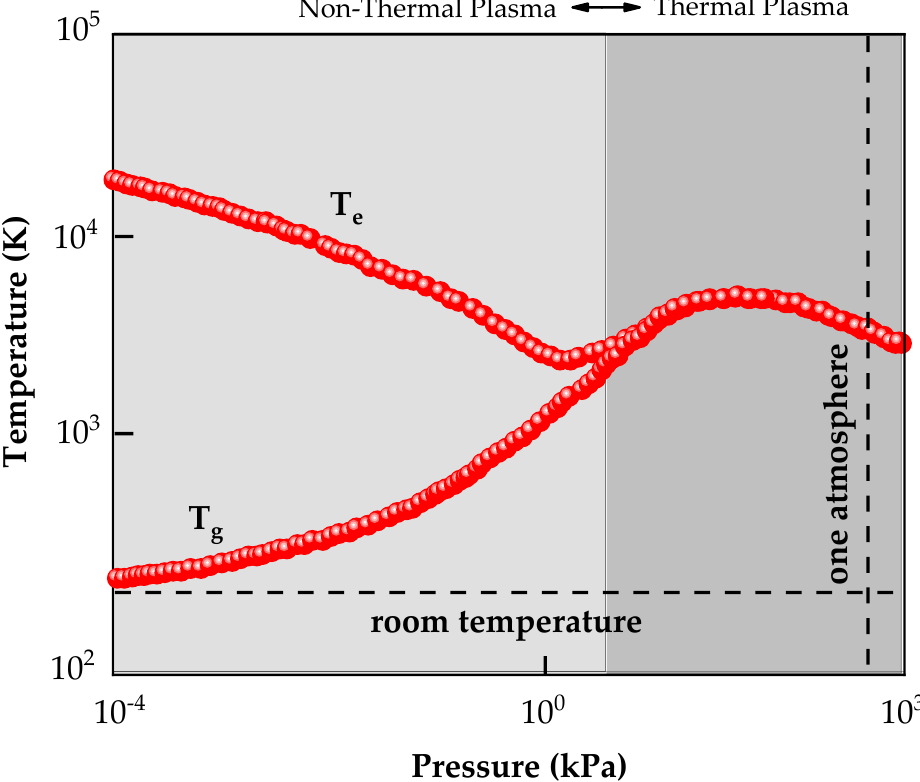
Figure 1. Schematic plot of the electron temperature (T e ) and the ions and neutral atoms, i.e., gas temperature (T g ) versus pressure. As can be seen, when the T g is much lower than the T e , the plasma is classified as non-thermal plasma. Adapted with permission from Ref. [3]. Copyright 2016, Else- vier.